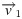
The effect of synaptic blockers.A) A raster plot of spike times for a sample cell prior to application of CdCl2. B) The eigenvalues produced from STC analysis showing three significant eigenvalues (arrows). C) A raster plot of spike times for the same cell as in (A) after application of CdCl2. While spontaneous spikes can be seen at times, long-latency activity was mostly abolished. D) The eigenvalues produced from STC analysis showing only one significant eigenvalue. E) The ERFs corresponding to v→1 before (left) and after (right) application of CdCl2. F) A comparison of the electrode amplitudes making up the ERFs of v→1, before and after application of CdCl2.